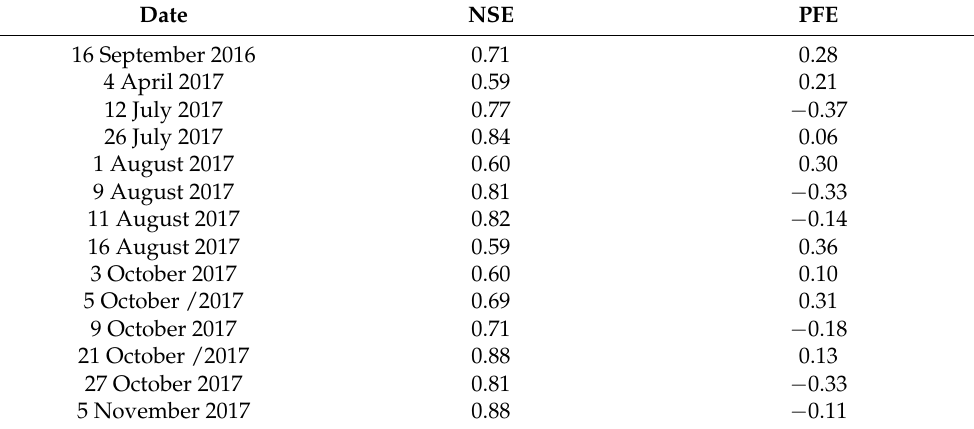
Table 1. Goodness-of-fit results for